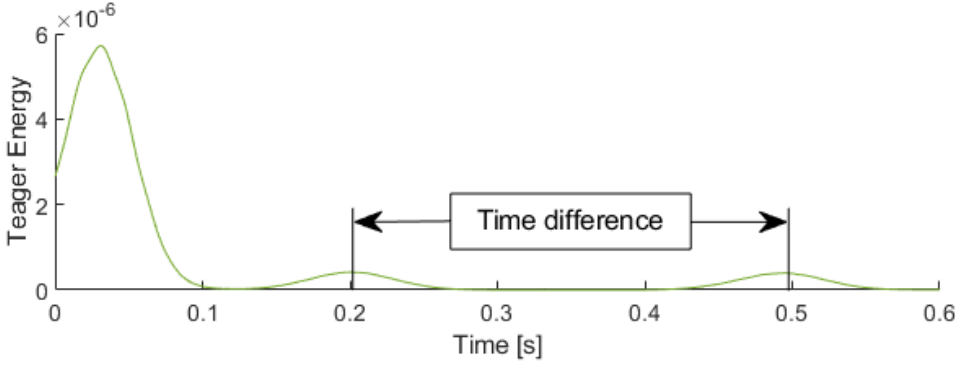
Figure 7. Teager energy of the rotor with one broken bar—1 BAR (filter centered at f 0 = 30 Hz).